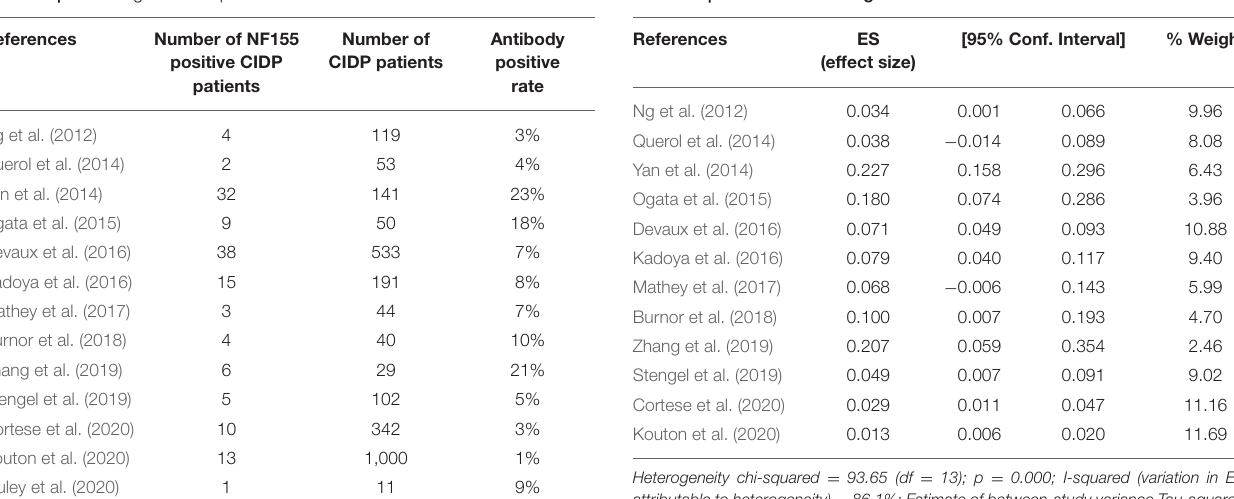
TABLE 1 | Percentage of CIDP patients with anti-NF155